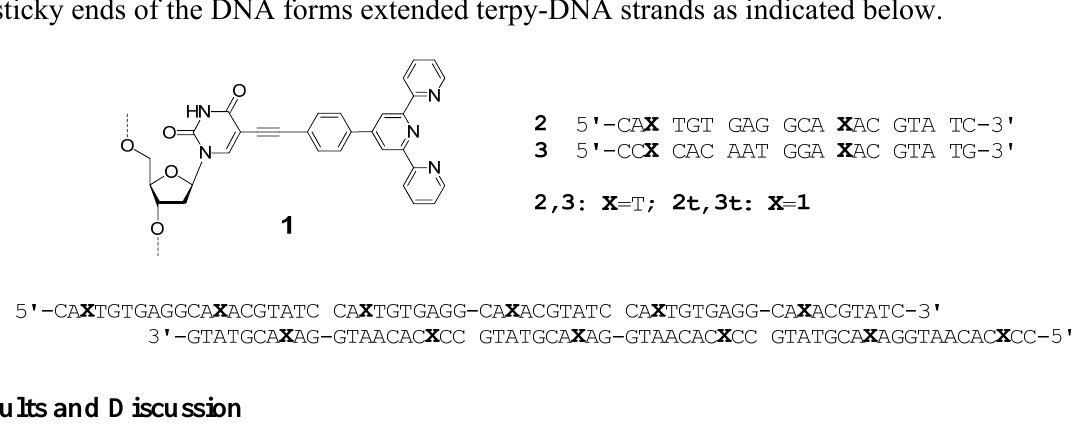
Figure 1. Structure of the terpyridine substituted thymidine monomer 1 as incorporated into the DNA strands, and sequences of the synthesised DNA strands. The assembly of the sticky ends of the DNA forms extended terpy-DNA strands as indicated